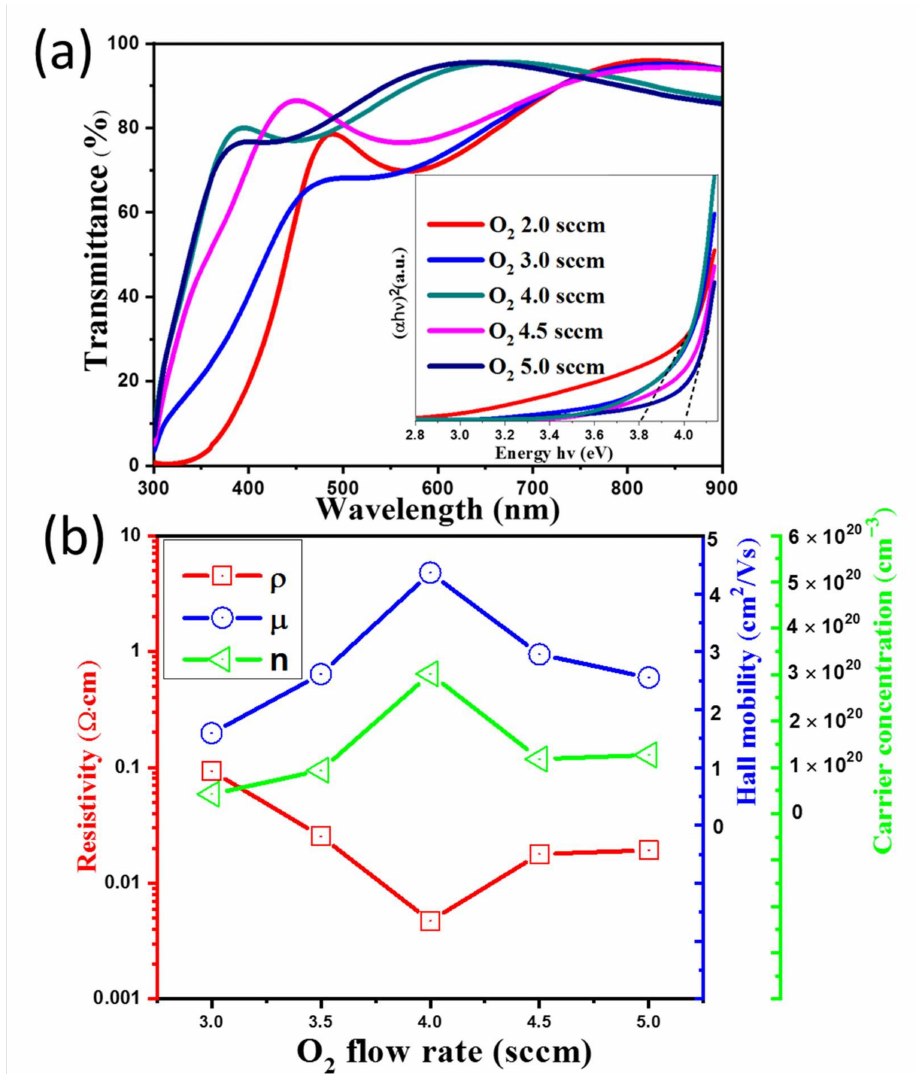
Figure 3. ( a ) Optical transmittance of Nb:SnO 2 thin films are plotted as a function of wavelength deposited at varying flow rates of oxygen, with an inset showing the fluctuation of band gap (Eg) at various oxygen flow rates. ( b ) The electrical characteristics of Nb:SnO 2 films are plotted as a function of various flow rates of oxygen deposited at room